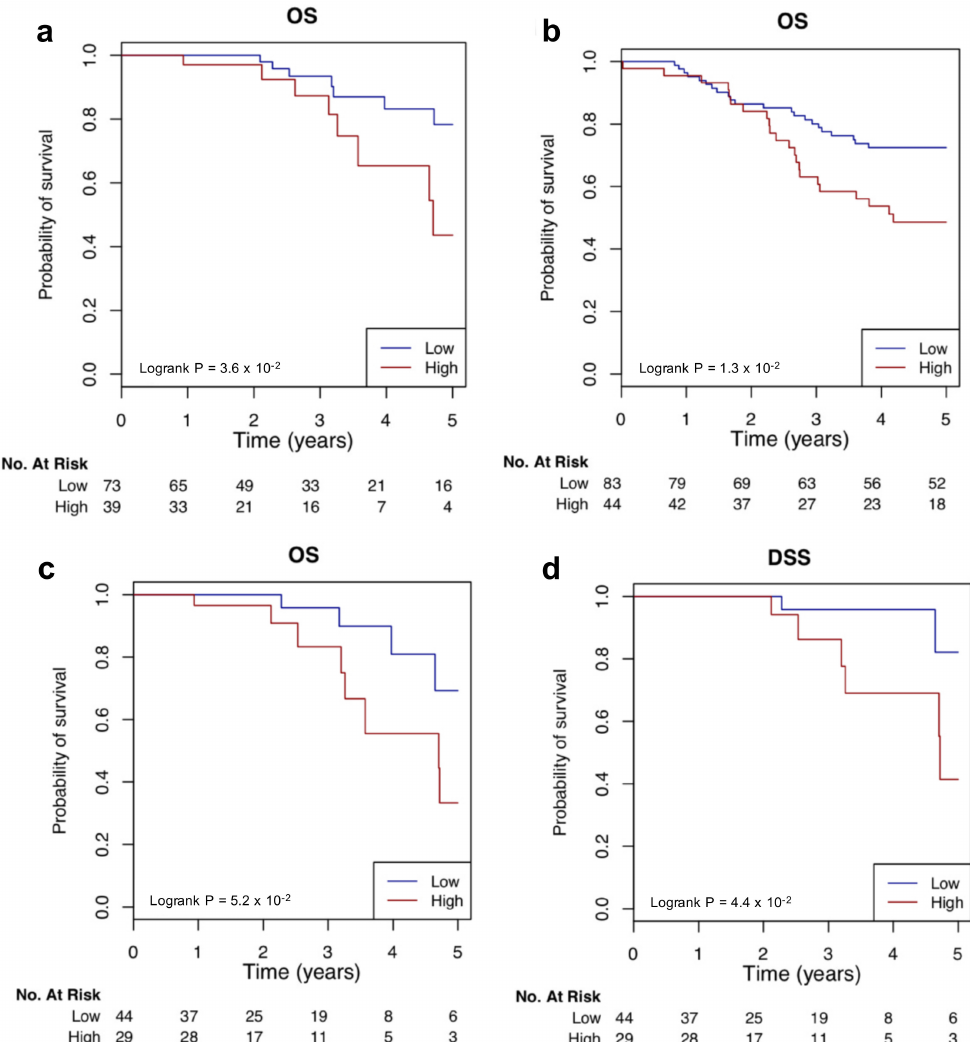
Figure 7. Kaplan–Meier survival analysis of the combined risk score. TN patients were divided into high-risk (“High,” red line) and low-risk (“Low,” blue line) groups according the 6 TF or 24 regulator combined risk scores. Survival fractions as a function of survival time (years) were then plotted for the two groups, and the significant separation of the two curves was assessed by log-rank test using the R package survcomp. The 6 TF combined risk score significantly stratified the TNBC samples from TCGA ( a ) and METABRIC ( b ) into high- and low-risk OS groups, respectively. The 24-regulator combined risk score significantly stratified the 112 TCGA TNBC samples into high- and low-risk groups in terms of OS ( c ) and DSS ( d